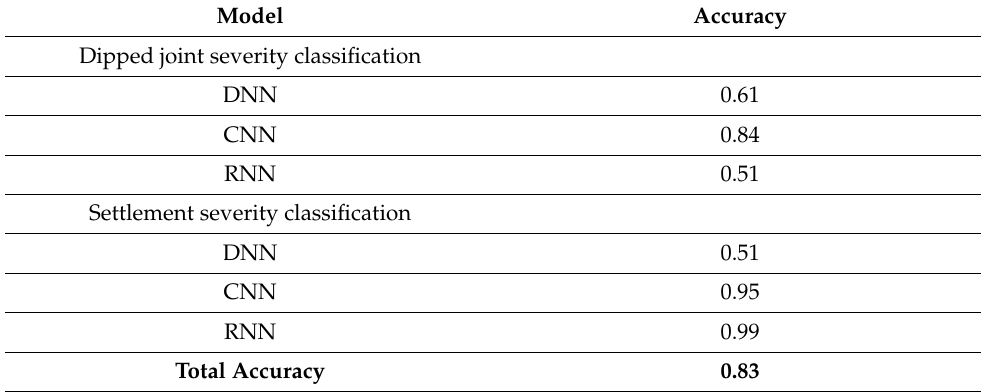
Table 9. Performance of each model for detecting dipped joint and settlement.